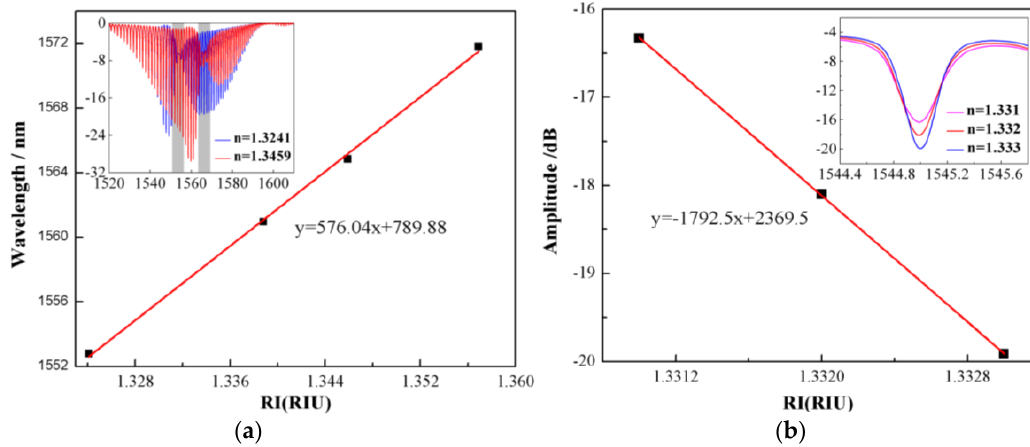
Figure 3. ( a ) The wavelength response of TFBG-SPR, attained by extracting the wavelength shifts of the most attenuated resonance in the spectrum (i.e., the SPR resonance). The measured sensitivity is 576.04 nm/RIU. ( b ) The amplitude variation of TFBG-SPR. The sensitivity is up to −1792.5 dB/RIU, obtained from the slope of the fitting curve.